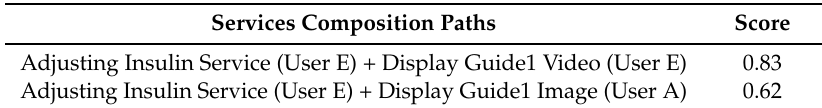
Figure 20. Semantic service discovery and different service composition paths. Table 6 Evaluations results [11].